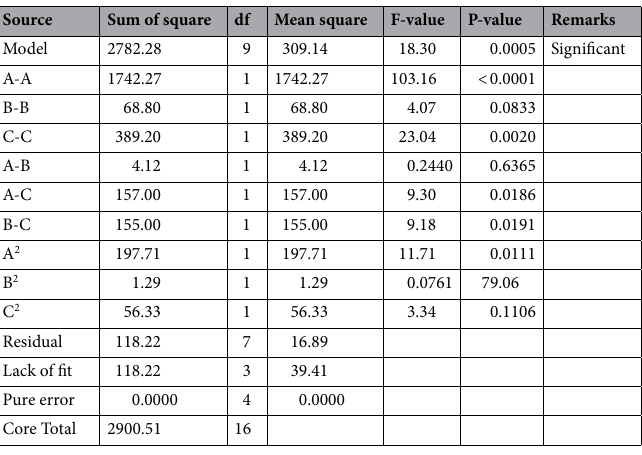
Table 3. Analysis of variance (ANOVA) for the biodiesel production from rapeseed oil over SSE@